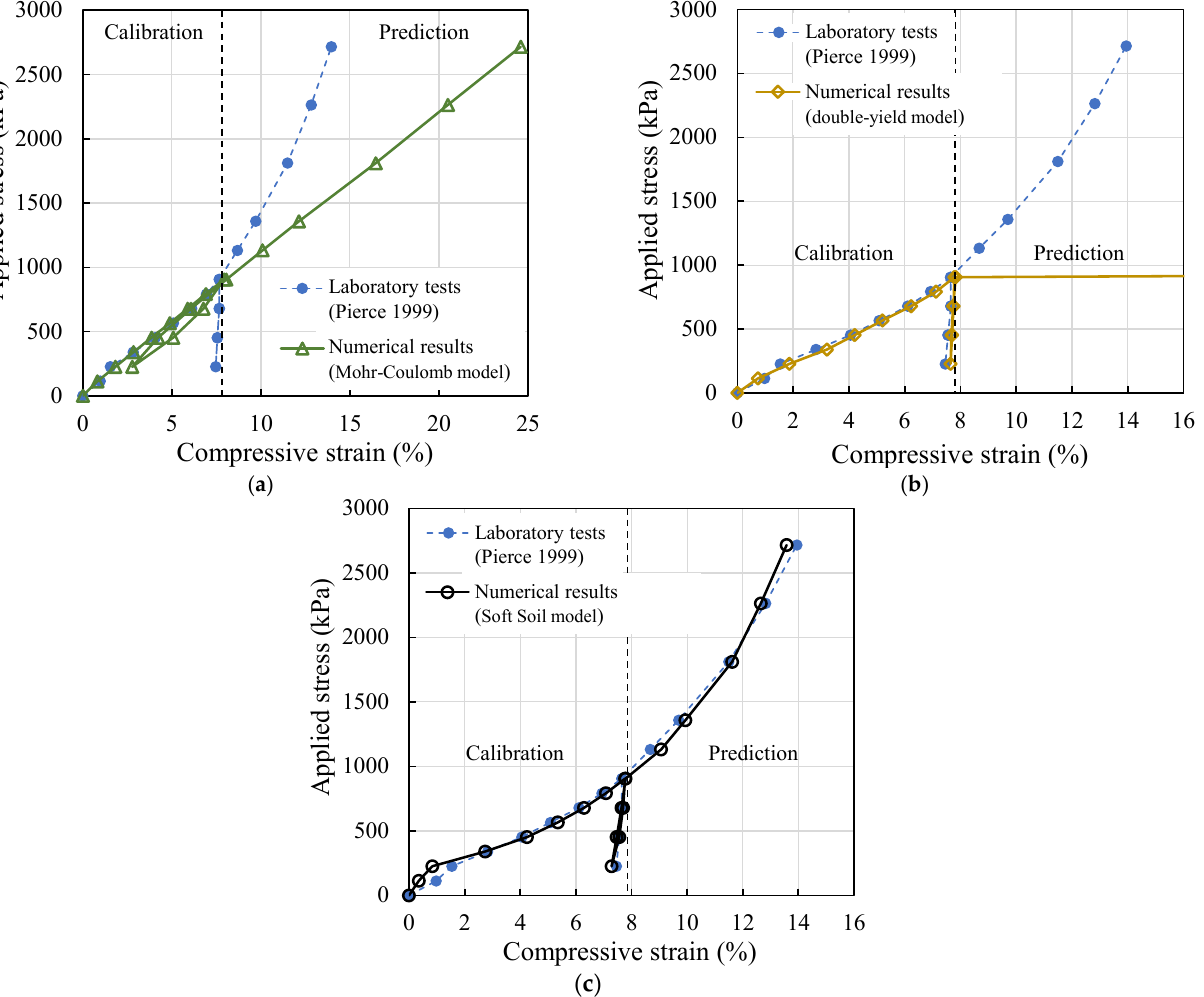
Figure 6. Comparisons between the experimental results of one-dimensional consolidation tests reported by Pierce [26] and the numerical results by applying the ( a ) Mohr–Coulomb; ( b ) double-yield; and ( c ) Soft Soil models for backfill with parameters in Table 1.